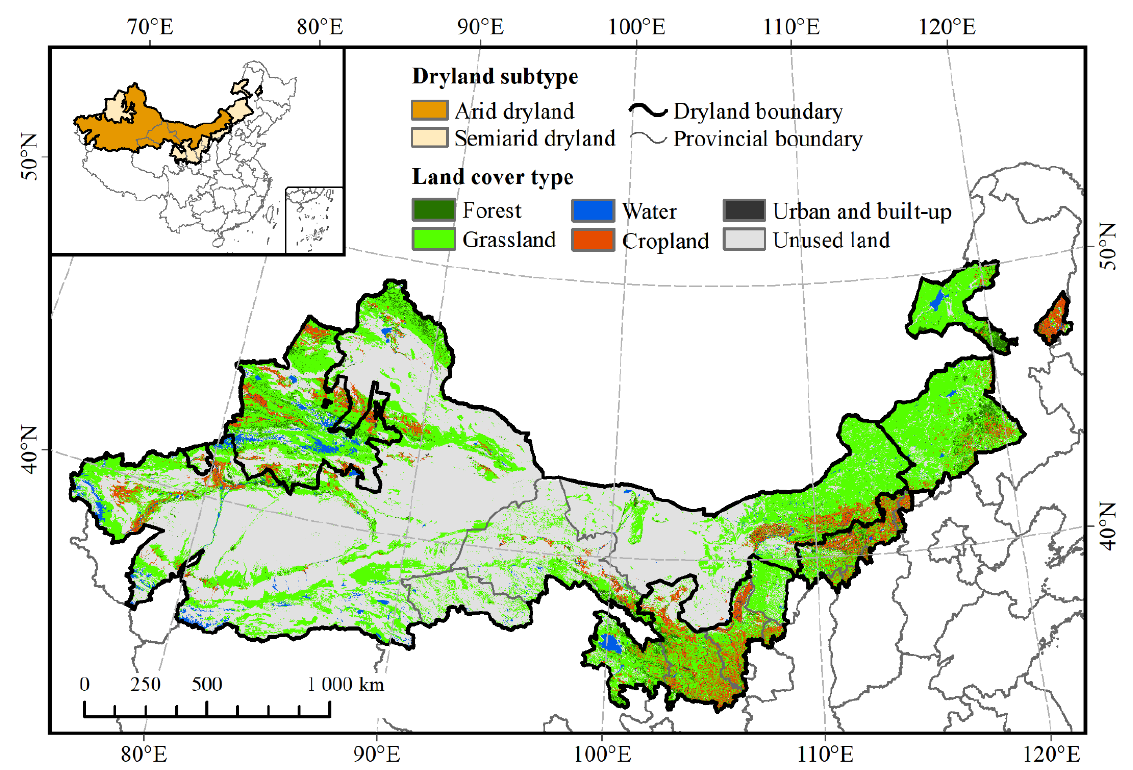
Figure 1. The location and land cover type of the drylands in northern China (land cover type is from LUCC 2000). The drought frequency in the DNC is higher than that in most other areas of China [32,33], and this area is prone to continuous drought for many years. The average proportion of area affected by drought to cultivated land area from 1978 to 2008 in North China and Northwest China ranked first and third, respectively, among the six regions of China (North China, Northeast China, Northwest China, Southwest China, East China and South Central China), according to the report in the Statistics of New China’s Agriculture in 60 Years [34]. Obviously, the northern region is relatively more vulnerable to the severe effects of drought. Due to the limitations of the climatic conditions, irrigated agriculture accounts for a large proportion of the DNC, especially in arid dryland (Table